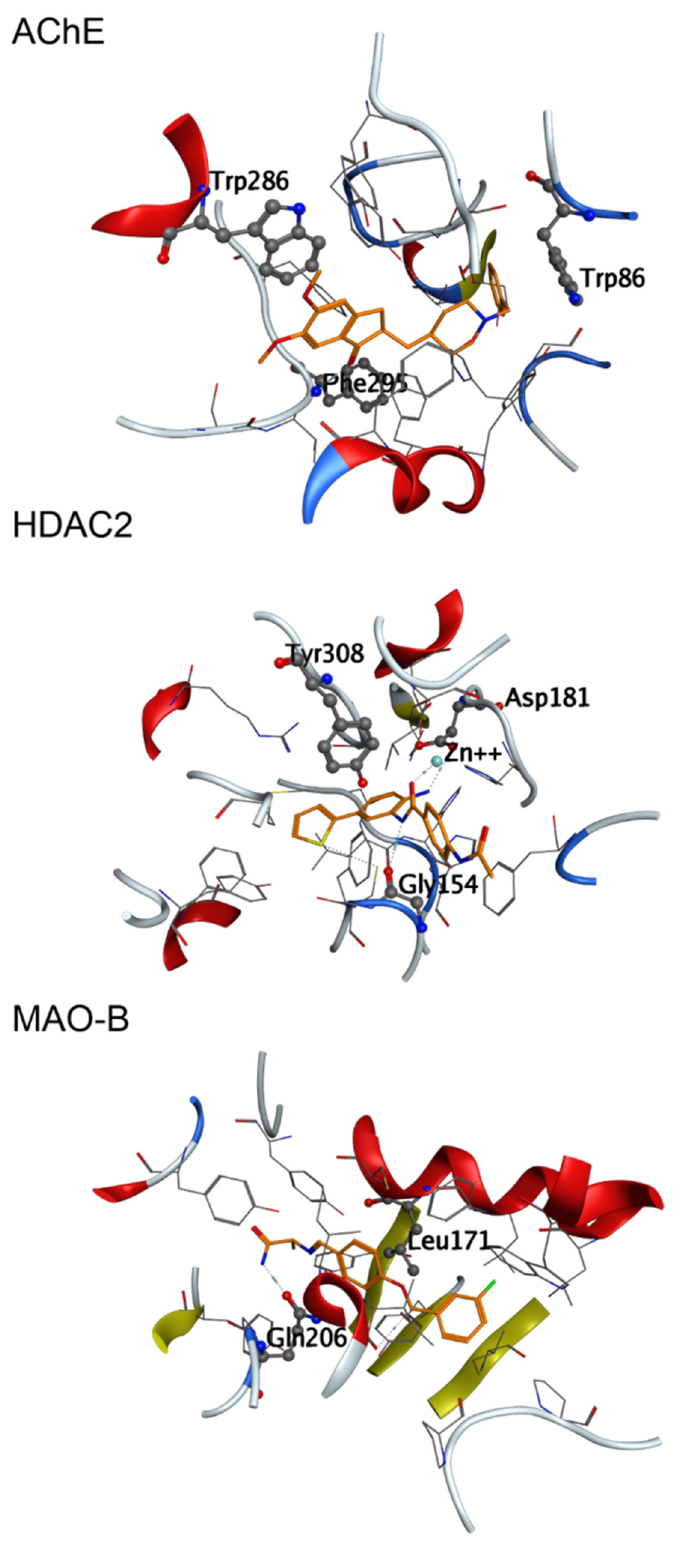
Figure 3. Active sites together with the bound reference ligands (in orange) of the selected proteins: the amino acids involved in specific interactions are presented in sticks & balls: AChE (Trp86, Trp286, Phe295); HDAC2 (Gly154, Asp181, Tyr308 and Zn 2+ cofactor, represented as a sphere); MAO-B (Leu171, Gln206).